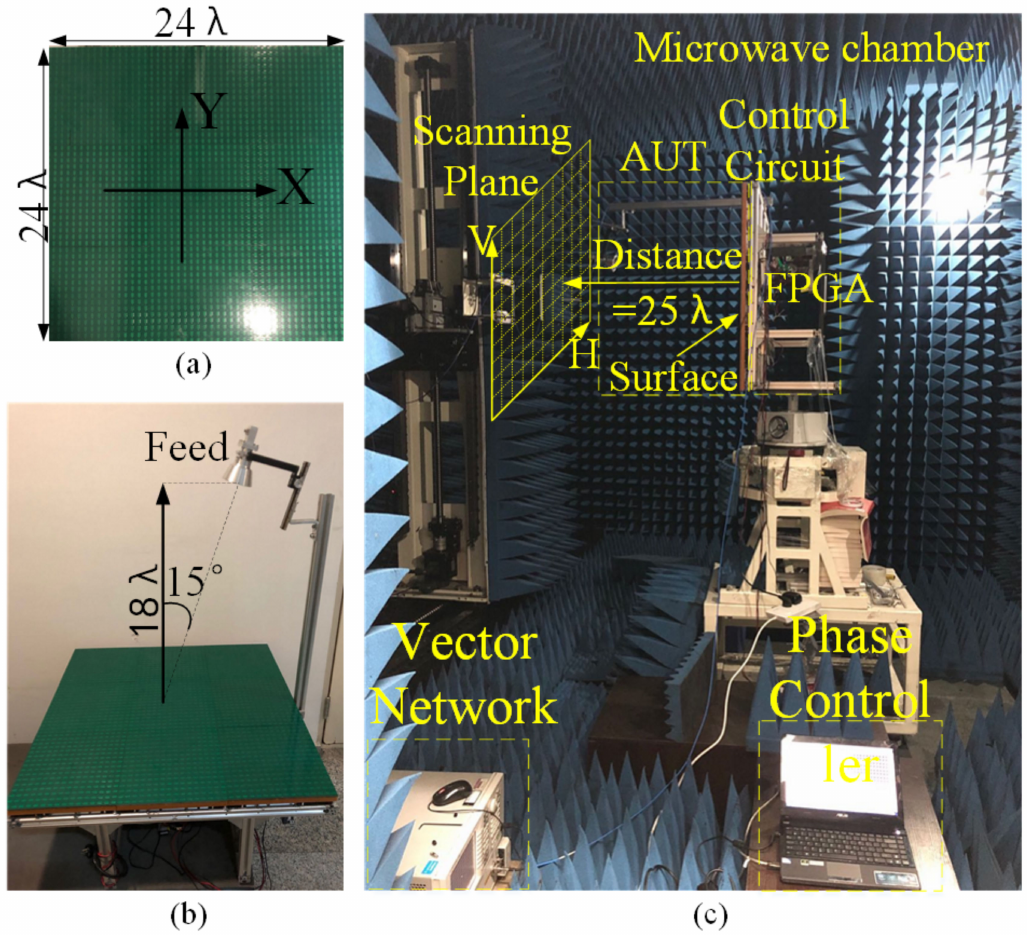
Figure 4. Antenna prototype and planar near-field scanning microwave chamber: ( a ) proposed 1-bit surface; ( b ) prototype of the reconfigurable reflectarray antenna; ( c ) test components and